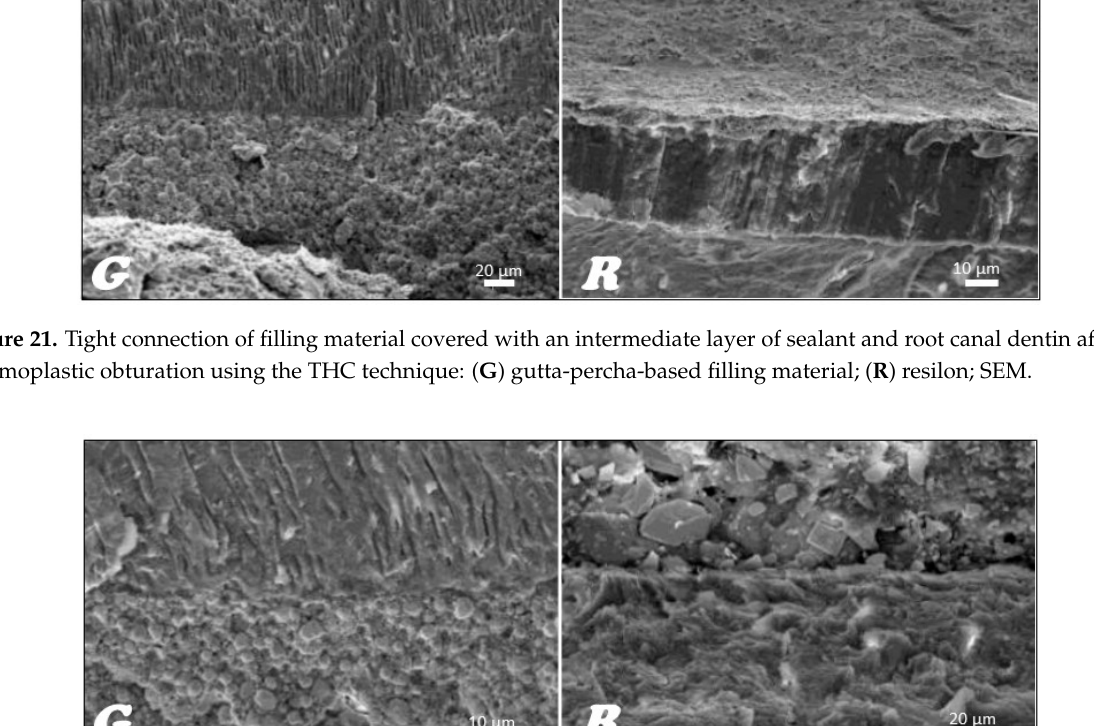
Figure 21. Tight connection of filling material covered with an intermediate layer of sealant and root canal dentin after hot thermoplastic obturation using the THC technique: ( G ) gutta ‐ percha ‐ based filling material; ( R ) resilon; SEM.